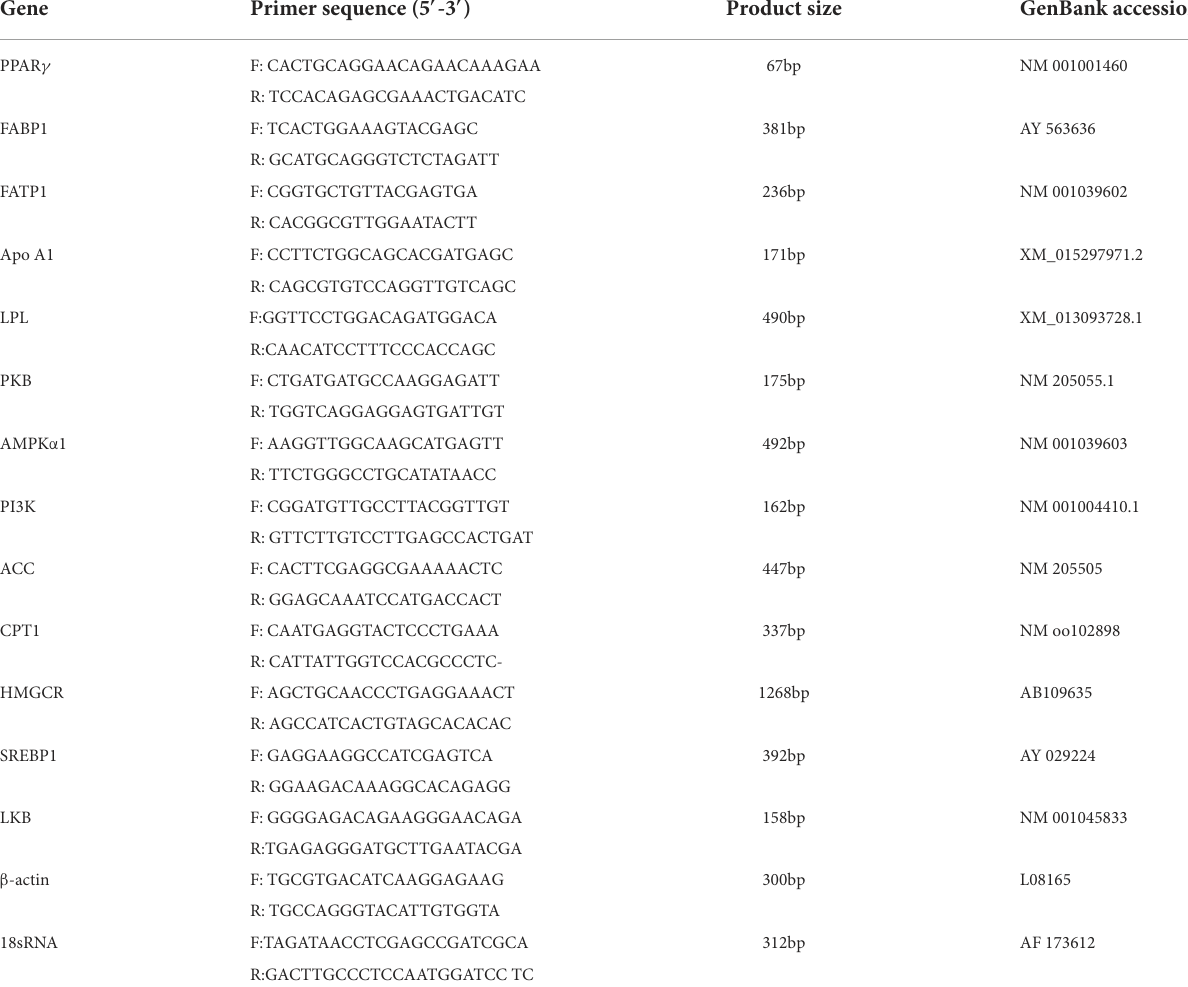
TABLE 2 Parameters of primer pairs for the genes. Gene Primer sequence (5